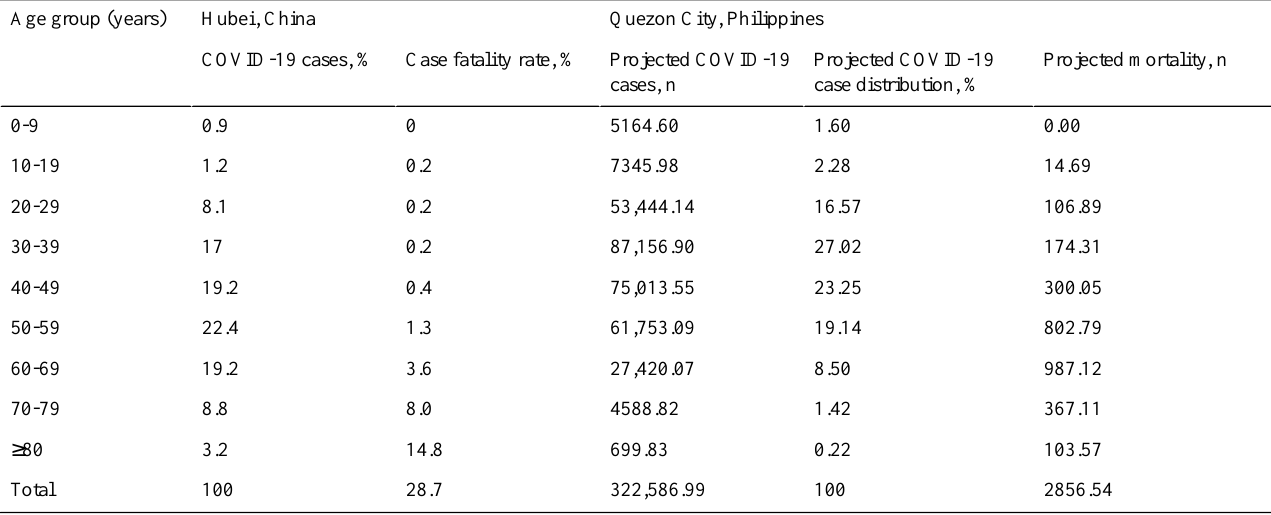
Table 1. Quezon City, Philippines, projection of COVID-19 cases and mortality using COVID-19 data from Hubei,